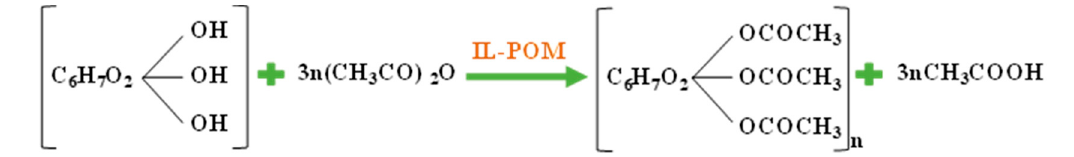
Scheme 1. Schematic presentation of the process of preparing cellulose triacetate (CTA) from corn